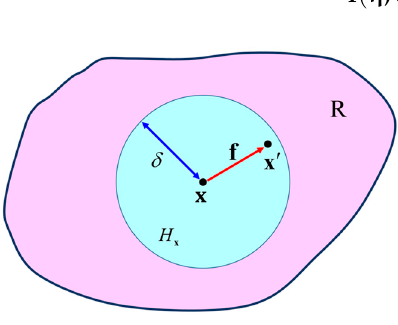
Figure 1. Schematic of peridynamic interactions.